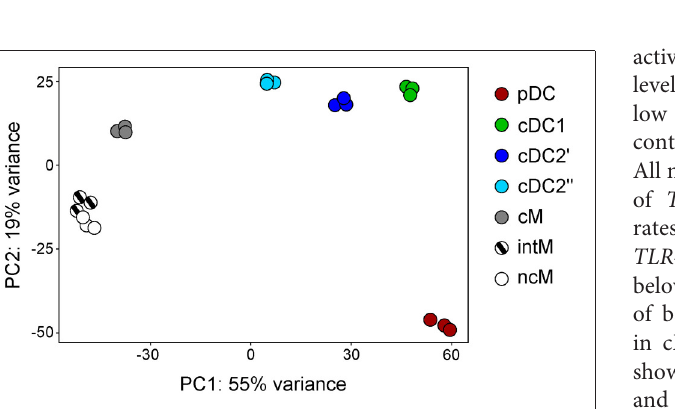
of these bovine subsets were most similar to human